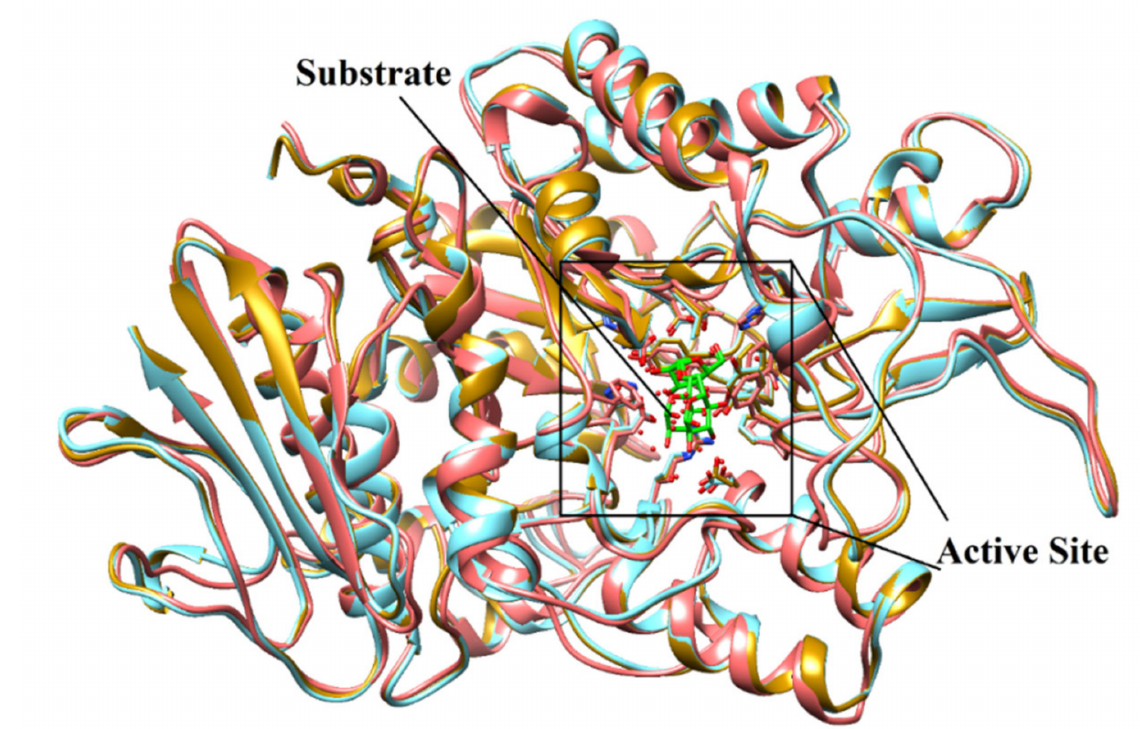
Figure 2. The superimposed view of model (coral ribbons) and templates [3AXH (golden ribbon) and 3A47 (Cyan ribbon)] shows the structural topology of the model is similar to its templates. The active site residues are shown in stick model. The substrate molecule (isomaltose) is depicted in green stick